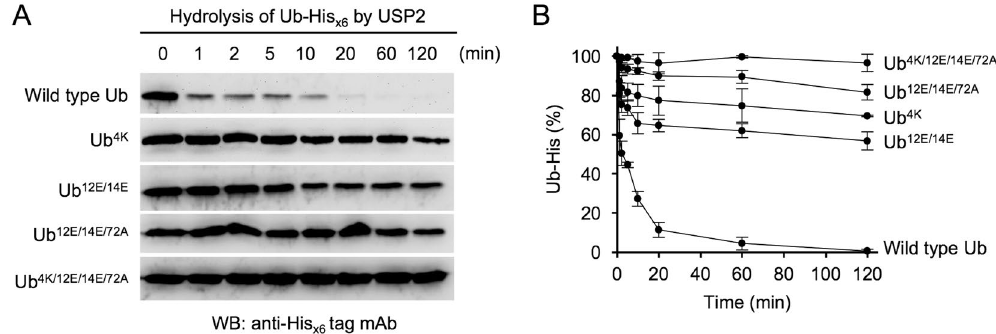
Figure 3. Comparison of the reaction kinetics of various Ub substrates catalyzed by USP2. ( A ) The Ub-His x6 mutants which can be cleaved by USP2 were selected to perform a time-course experiment. Wild-type Ub- His x6 and indicated mutants (9.2 μ M) were incubated with USP2 (4.75 μ M) at 37 °C for 1–120 min. At each time point, reactions were terminated by adding 4X SDS-PAGE sample buffer and incubating at 100 °C for 10 min. All of collected samples were separated on 16.6% SDS-PAGE and further analyzed using western blotting with the anti-His x6 tag antibody. Data are representative of three independent experiments. The full-length blots are presented in Supplementary Figure S2. ( B ) The signal intensity of three independent experiments was measured by a densitometer and processed by ImageJ. The results of the measurement were interpreted as a line chart. Values are means ± S.D. from three independent